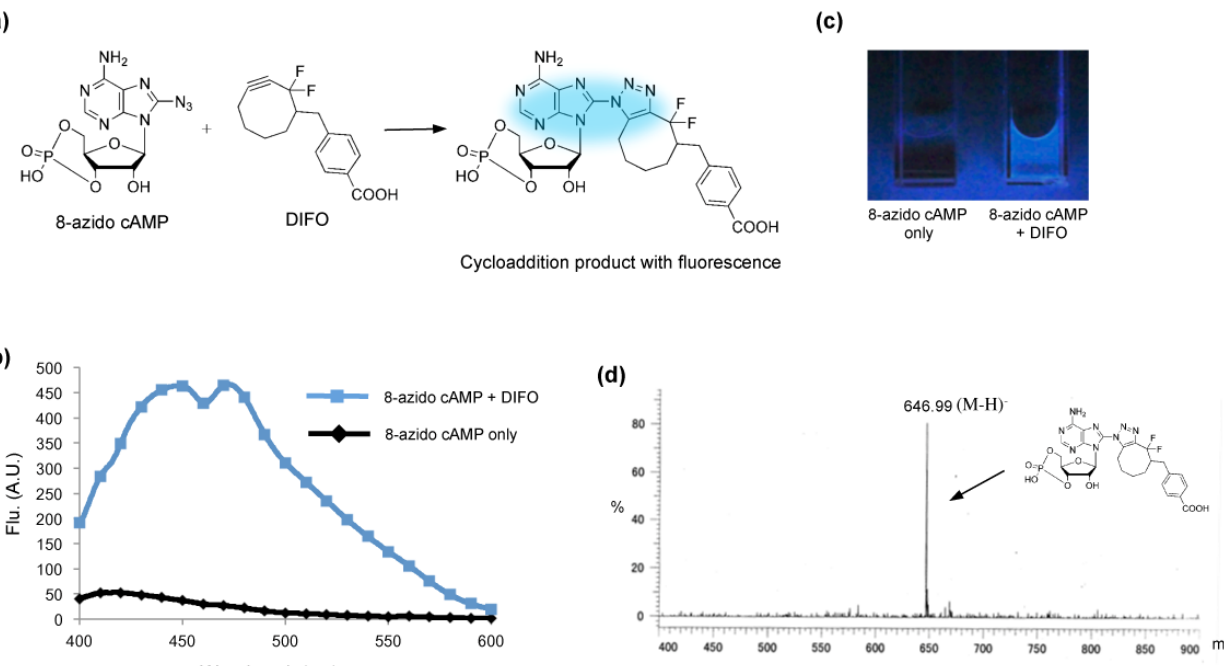
Figure 1. Azide-alkyne cycloaddition in Cu-free conditions. ( a ) Two molecules, 8-azidoadenosine 3 ′ ,5 ′ -cyclic monophosphate (8-azido cAMP) and a DIFO reagent, were conjugated by Cu-free azide-alkyne cycloaddition. The Cu-free reaction adds a triazole ring at the 8-position of 8-azido cAMP, resulting in a nucleoside analog that shows fluorescence. ( b ) Fluorescence spectra for the cycloaddition reaction product and 8-azido cAMP. Reaction conditions: [8-azido cAMP] = 1 mM, [DIFO] = 1 mM, 37 °C, 5 h. ( c ) Fluorescence image of the cycloaddition reaction product (right) and 8-azido cAMP (left) after illumination with a UV lamp (365 nm). ( d ) ESI-MS spectrum of the cycloaddition reaction